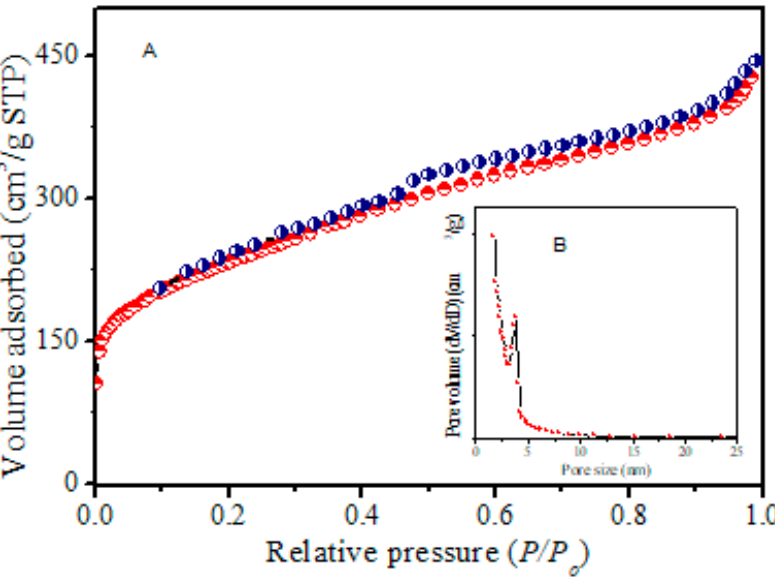
Figure 4. ( A ) N 2 isotherms of rice starch-based mesoporous carbon RSNMC; ( B ) The inset shows the pore size distribution of RSNMC. Table 1. Surface structural properties of pure SBA15 silica template and RSNMC.